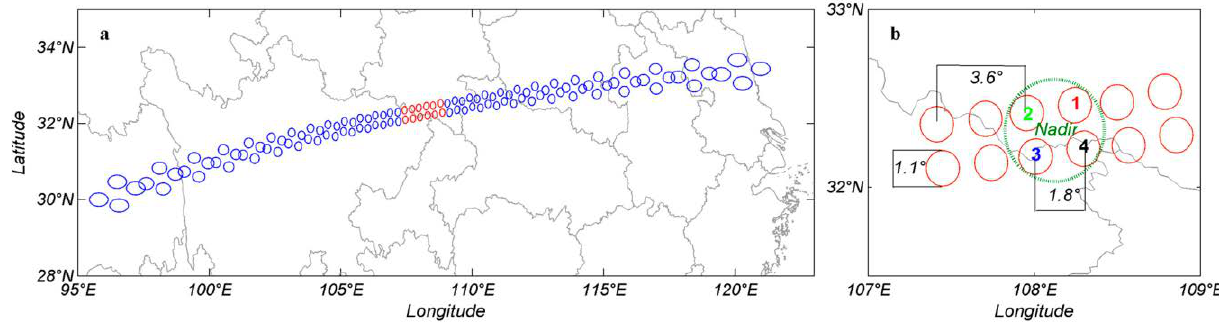
Figure 1. The HIRAS ground footprints from ( a ) one single scan line, ( b ) the central FORs of the scan line.